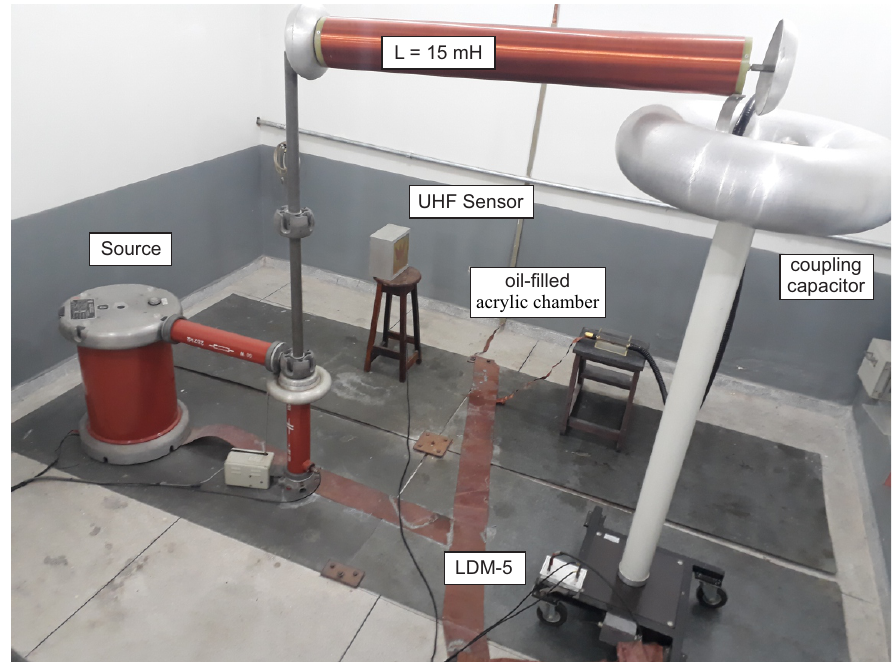
Figure 15. Photograph of the PD measurement setup.